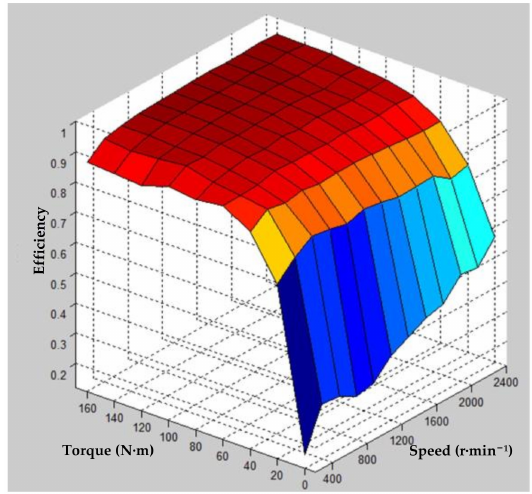
Figure 9. Three dimensional curves of efficiency.